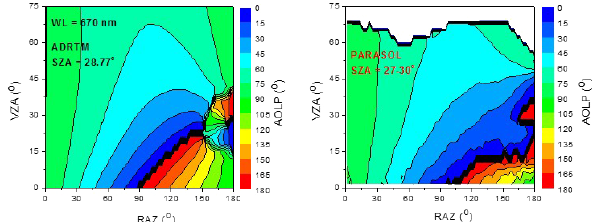
Figure 10. Comparison of the modeled AOLP of desert-reflected solar light with those from the PARASOL data at the wavelength of 670nm. The SZA is 28.77 ◦ in the modeling. The SZA is in the bin of 27–30 ◦ for the PARASOL data.